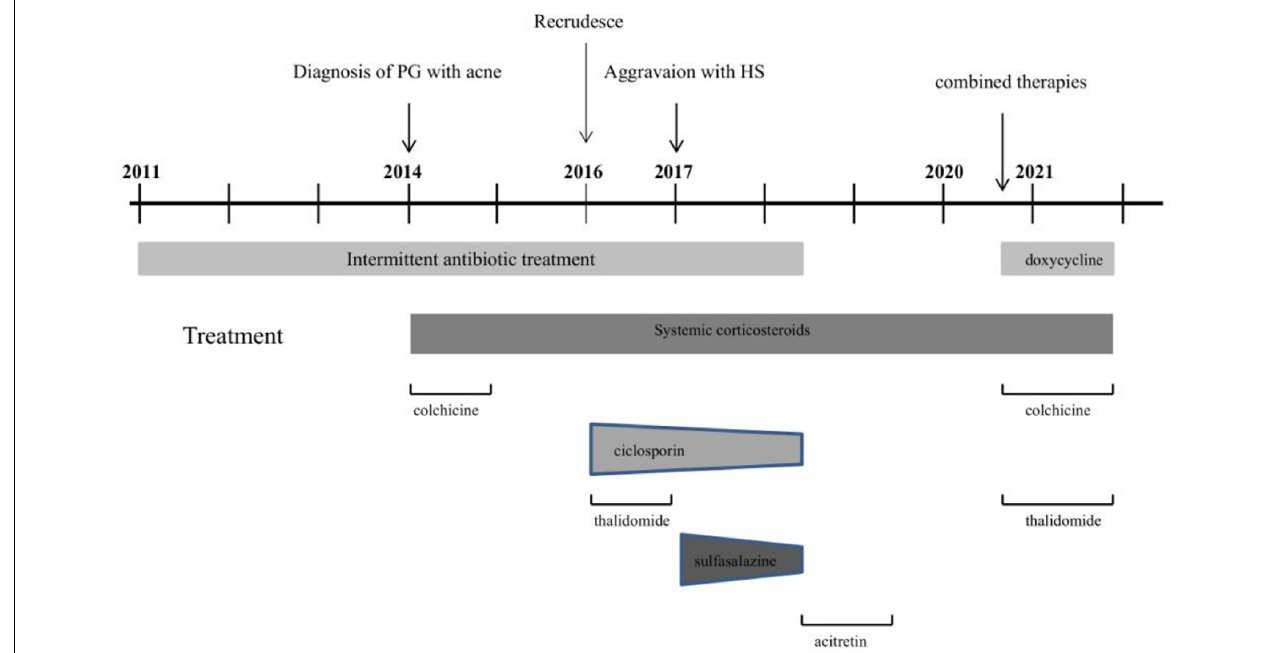
FIGURE 3 | Course of disease in PASH patient from 2011 to 2021.